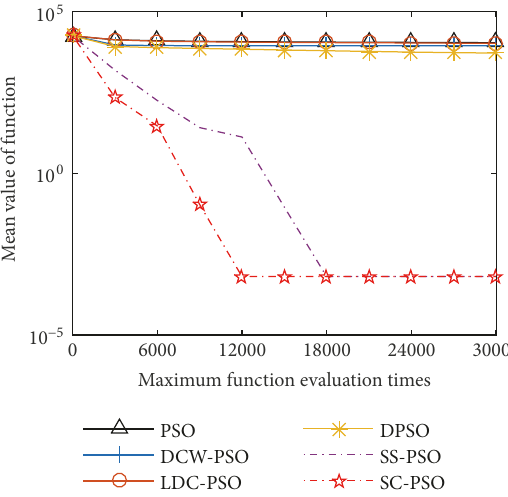
Figure 6: The function f 4 iterates over the curve. Figure 7: The function f 5 iterates over the